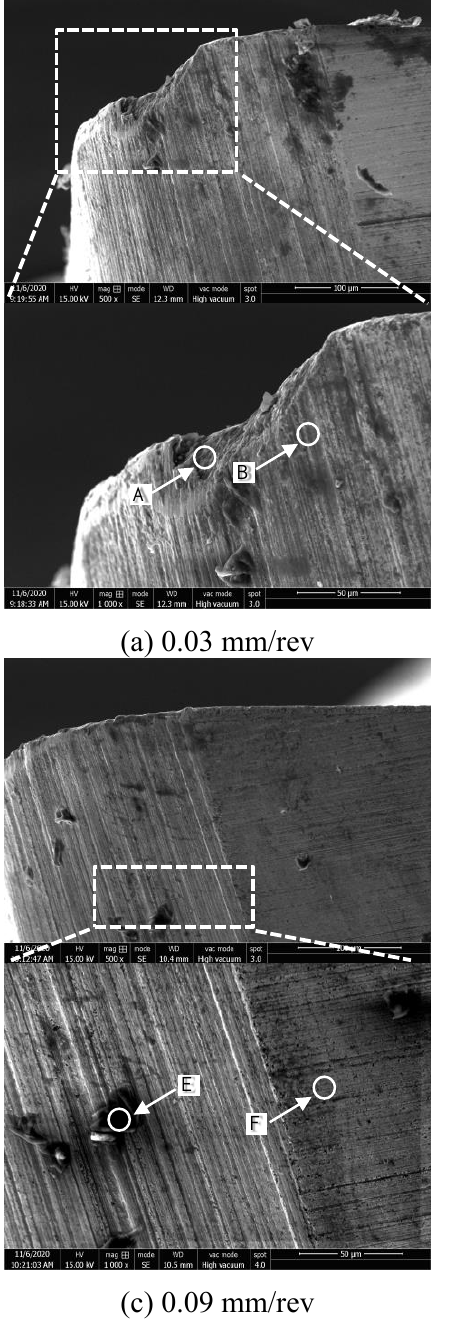
Figure 10. The wear morphology of flank face after milling at different feed (where cutting speed is 900 m/min, cutting depth is 0.5 mm and cutting width is 3 mm). ( a ) 0.03 mm/rev; ( b ) 0.07 mm/rev; ( c ) 0.09 mm/rev; ( d ) 0.11 mm/rev. At 0.07 mm/rev, Figure 11c,d illustrates that the flank face is mainly composed of tungsten element of the tool matrix, aluminum element and oxygen element. Figure 11e,h shows that the tool flank face is also mainly tungsten element of the tool matrix at 0.09 mm/rev and 0.11 mm/rev, which indicates that almost no adhesive wear was generated on the flank face comparing with the wear mechanism of the rake face.